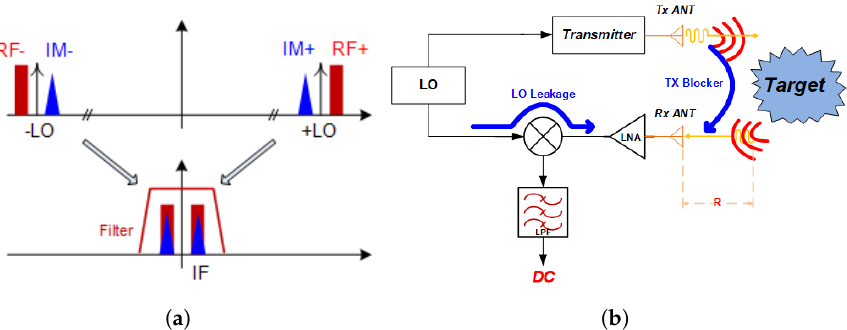
Figure 11. Disadvantage of direct conversion receiver architecture. ( a ) Image signal. ( b ) LO and TX leakage.